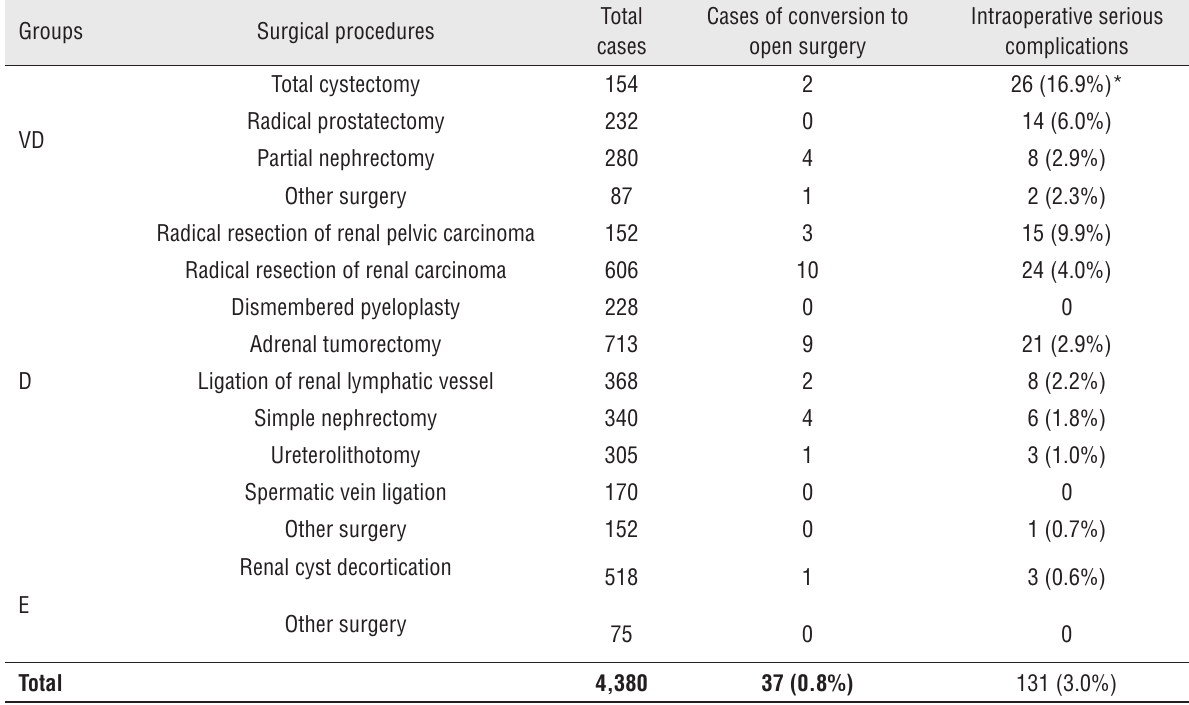
Table 2 - The intraoperative serious complications among diverse surgical procedures.